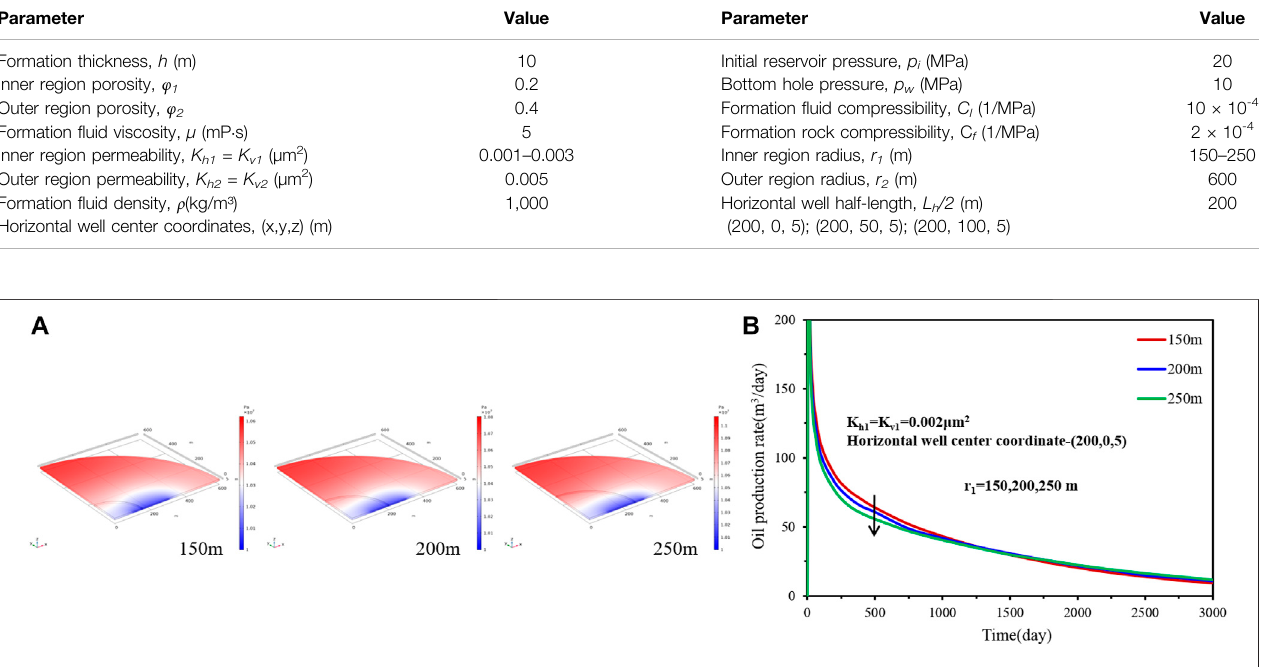
FIGURE 10 | Effect of inner region radius on (A) transient pressure and (B) rate decline performance.